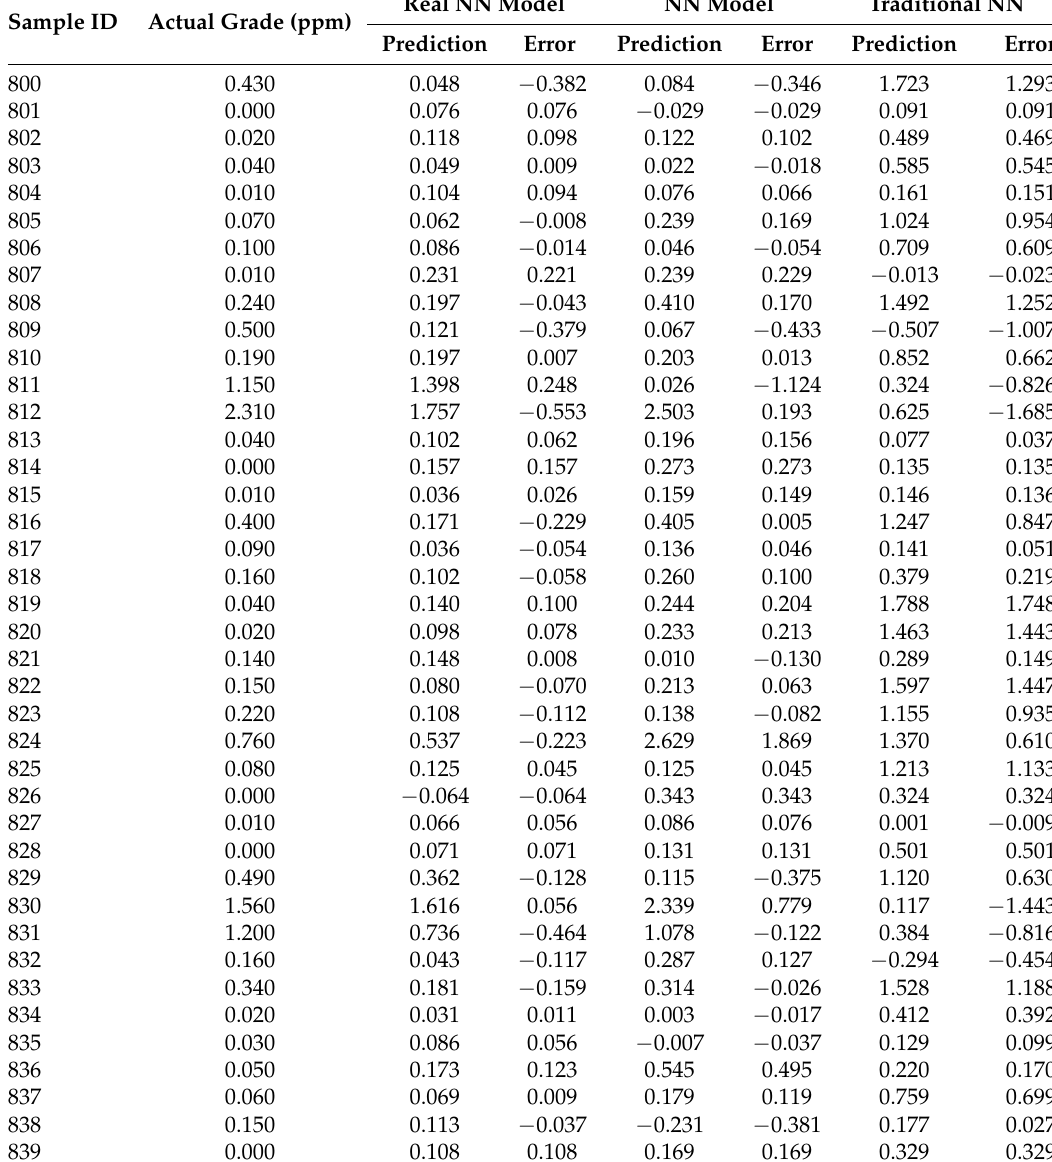
Table 10. Simulation 23, Comparison of NN models